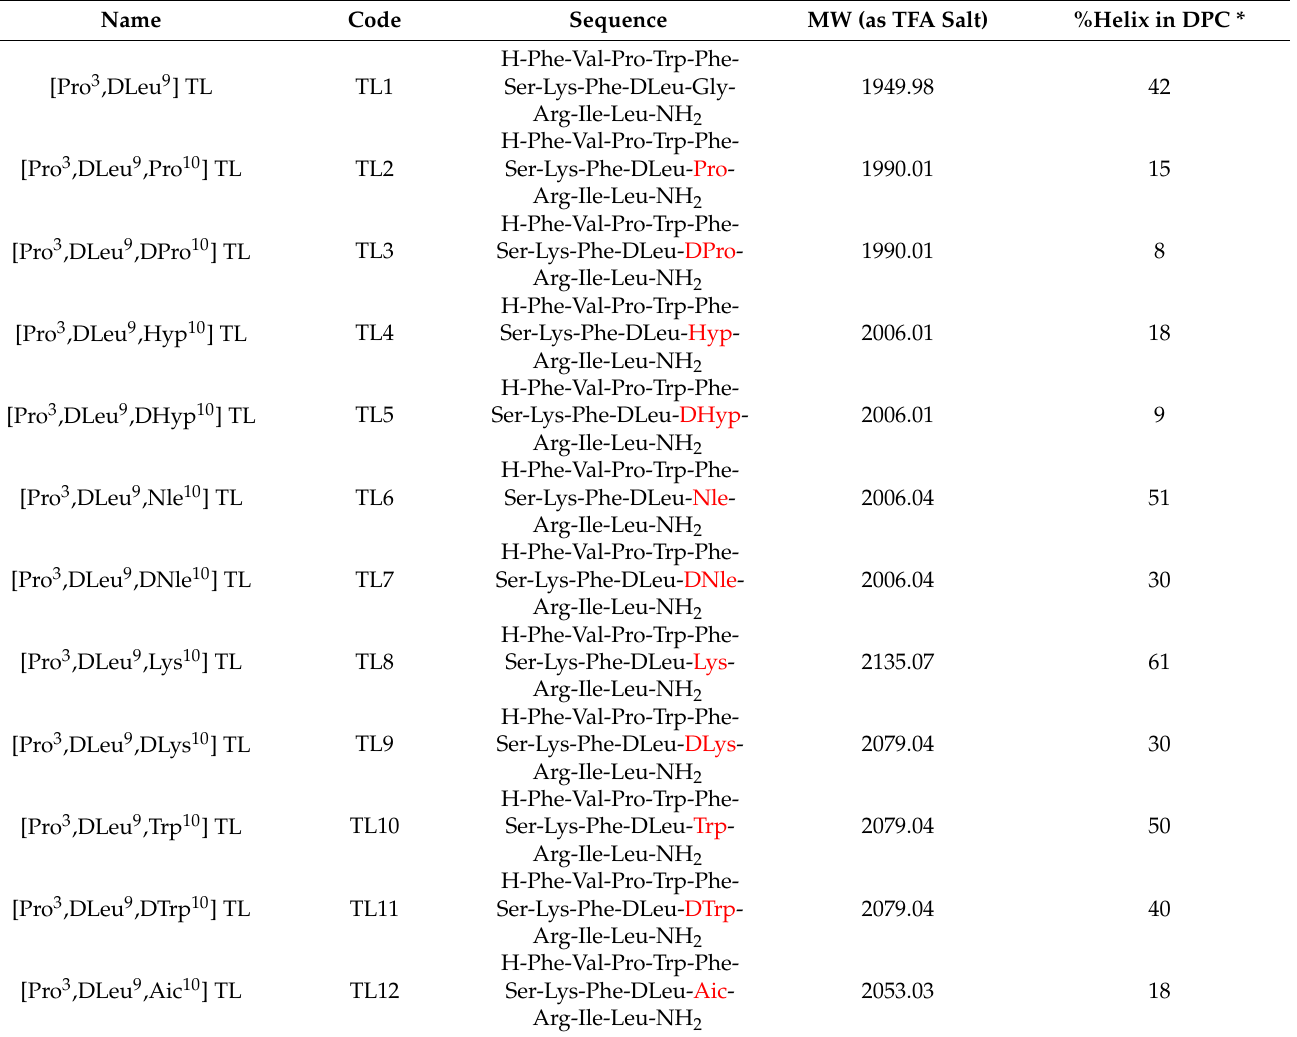
Table 2. Names, codes, sequences, and some properties (molecular weight and helical percentage) of TL1 and Gly 10 -replaced TL1